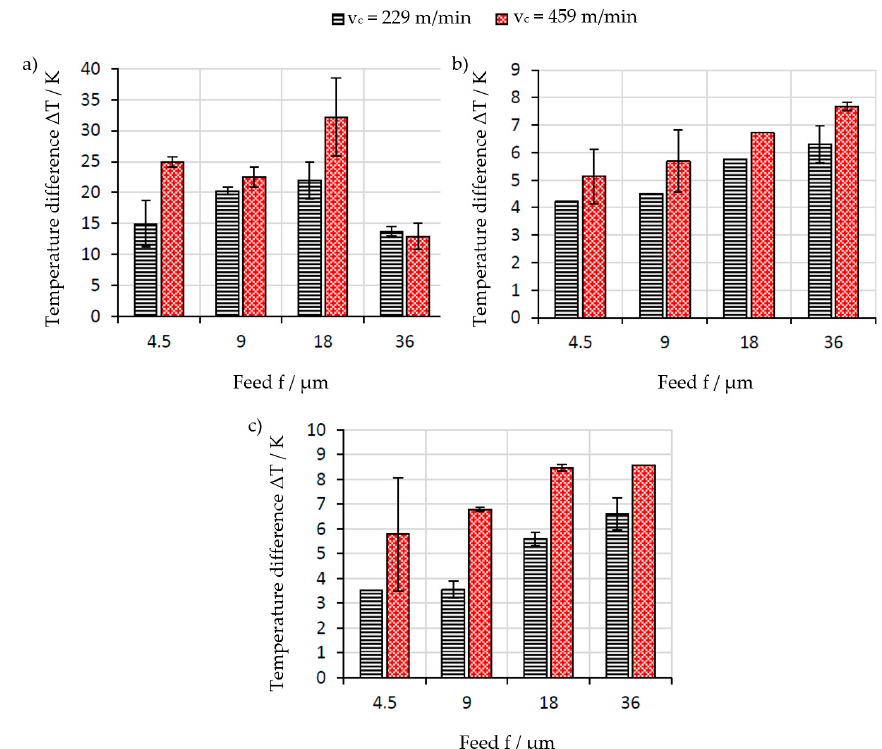
Figure 9. Average maximum temperature difference from room temperature for ( a ) steel, ( b ) alu- minum, and ( c ) Cu-OF workpieces at different feeds and cutting